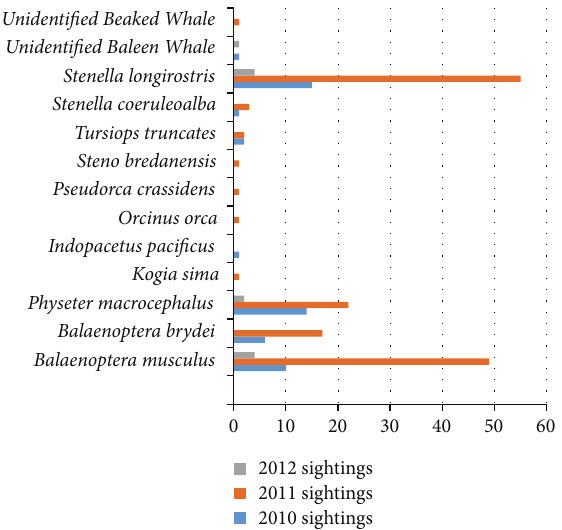
Figure 3: No. of sightings of individual species per year.